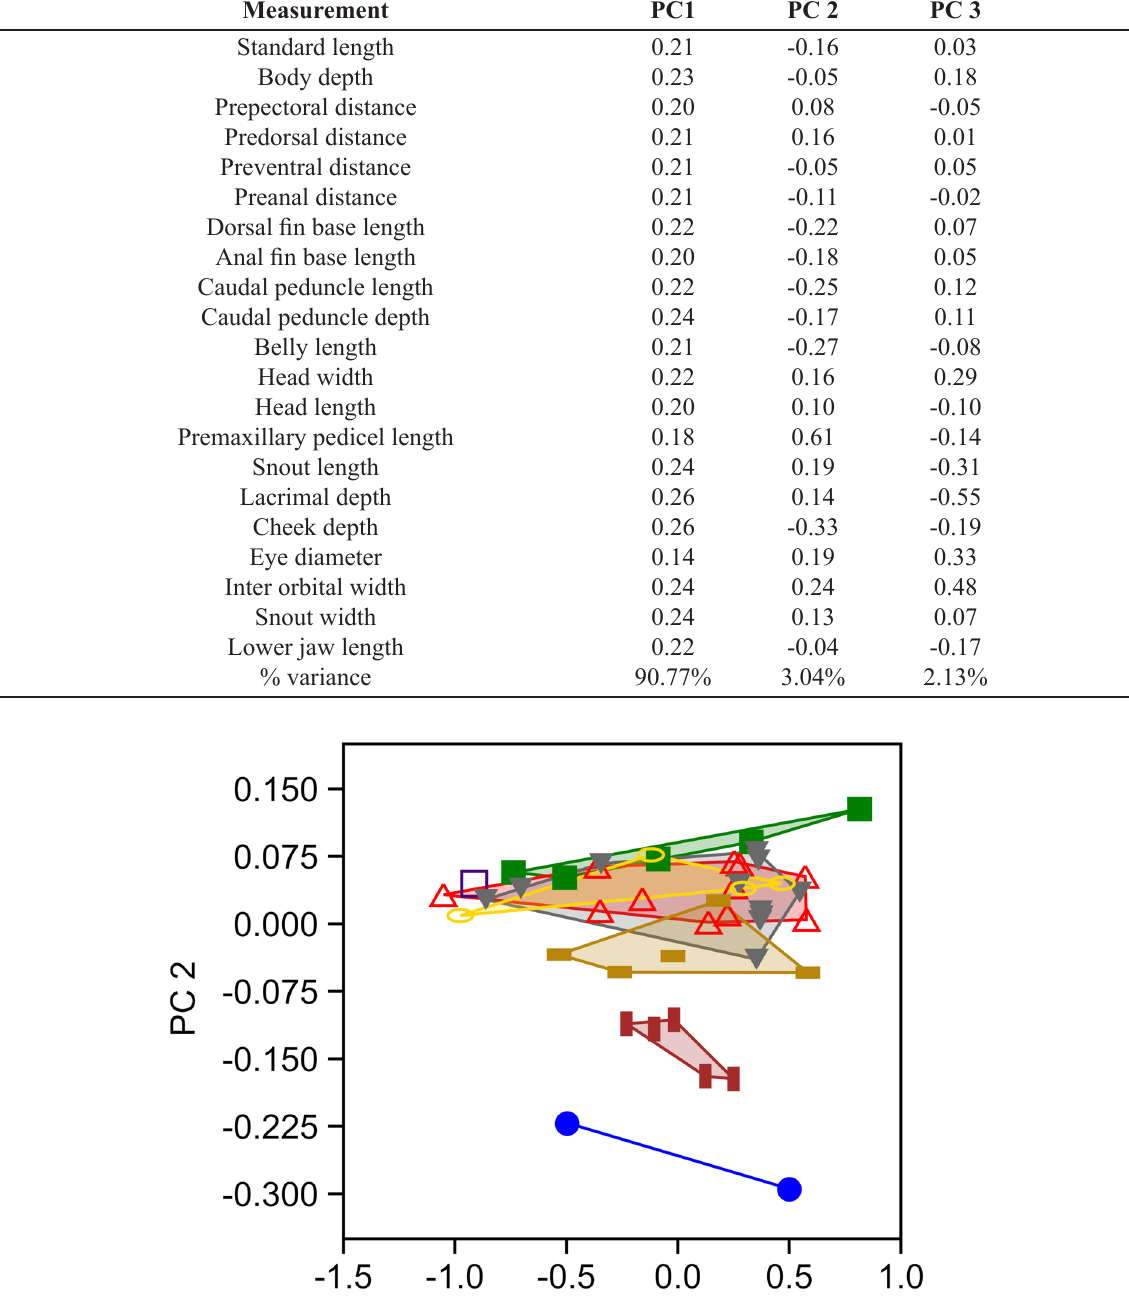
Table 1. Loadings of PC 1, PC 2 and PC 3 of the principal component analysis of 21 log-transformed measurements of all specimens in the analysis.